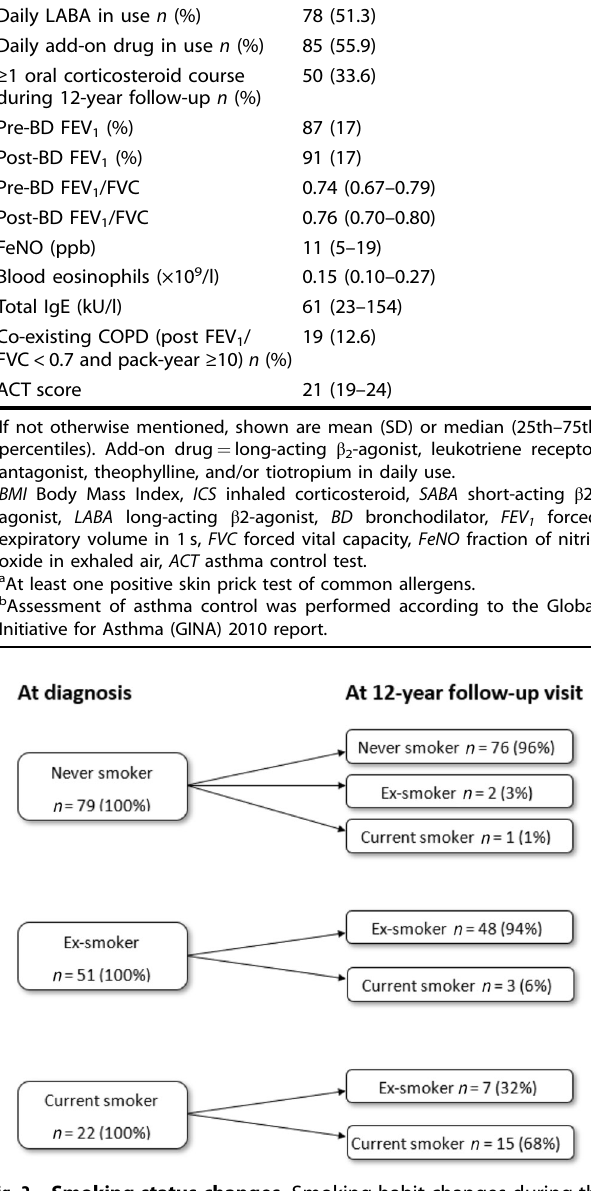
Fig. 2 Smoking status changes. Smoking habit changes during the 12-year